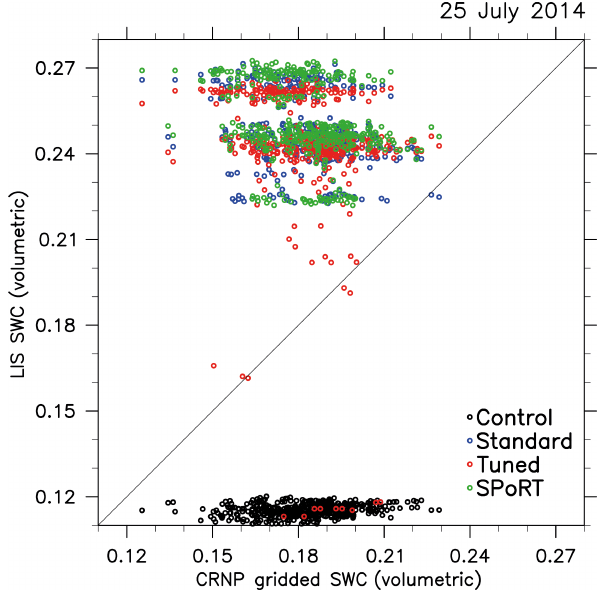
Figure 8. Scatter plot of the grid-cell soil water content given by the CRNP gridded soil moisture product as compared to the LIS